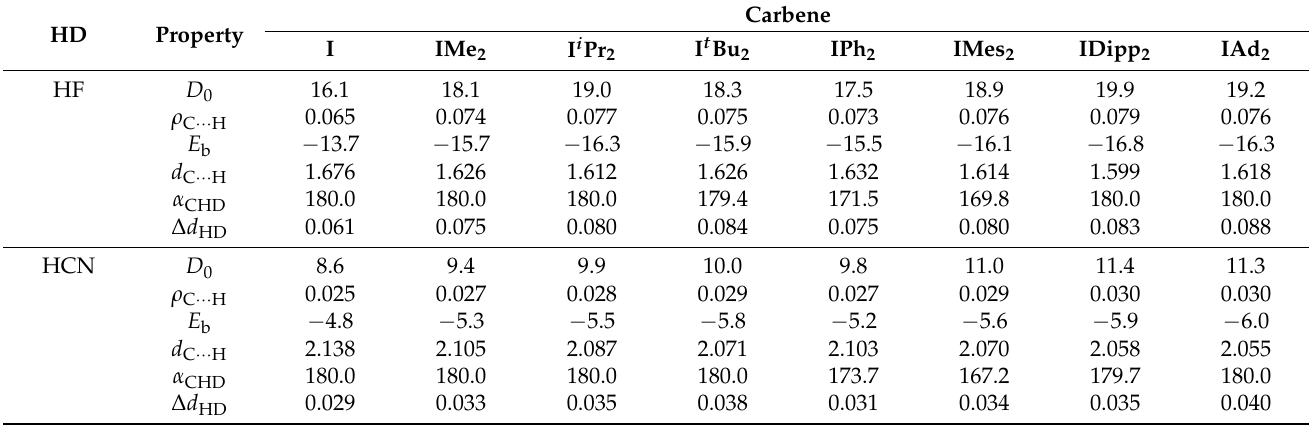
Table 1. Values of selected parameters characterizing the C · · · H-D hydrogen bond or the proton- donor molecule in the IR 2 · · · HD dimers (I = imidazol-2-ylidene; R = Me, i Pr, t Bu, Ph, Mes,